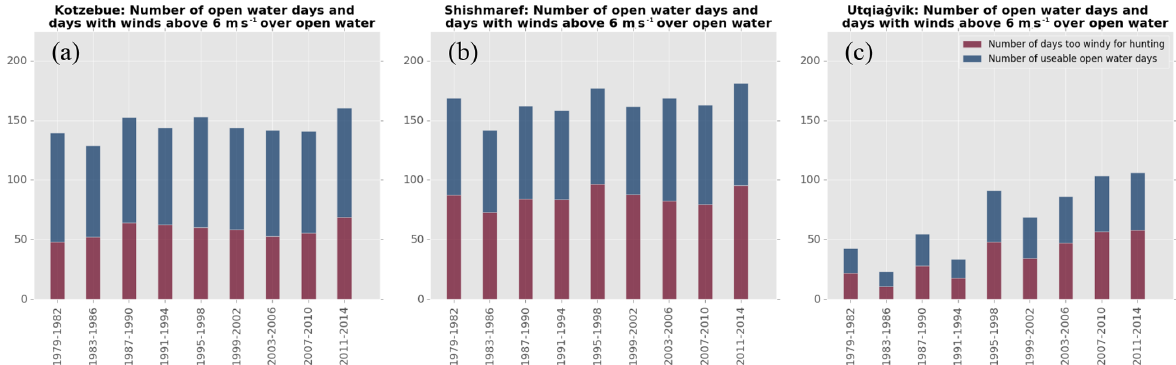
Figure 7. The number of days deemed too windy for boat travel for subsistence hunting ( > 6ms − 1 , Ashjian et al., 2010) are increasing along with the increasing number of open water days (number of days less than 15% sea ice concentration). Data are taken from the WRF- downscaled ERA-Interim